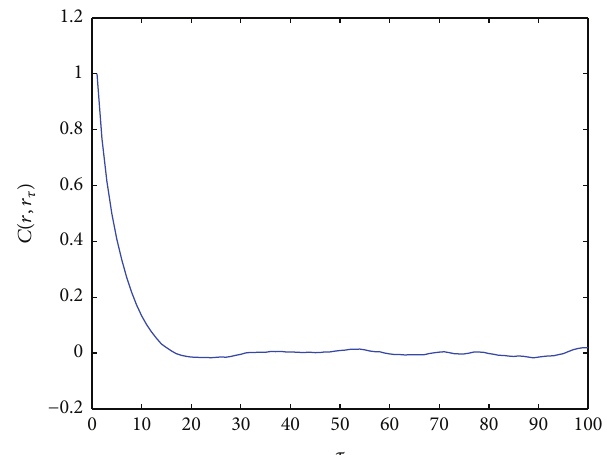
Figure 7: Autocorrelation function of the log returns of the realization shown in Figure 3.